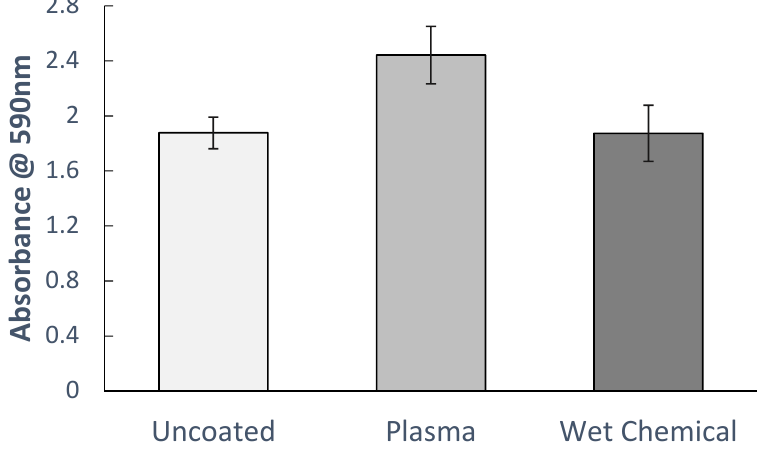
Figure 12. MTT assay at 24 h from human epithelial carcinoma (HeLa) cells. Results are average of six readings.